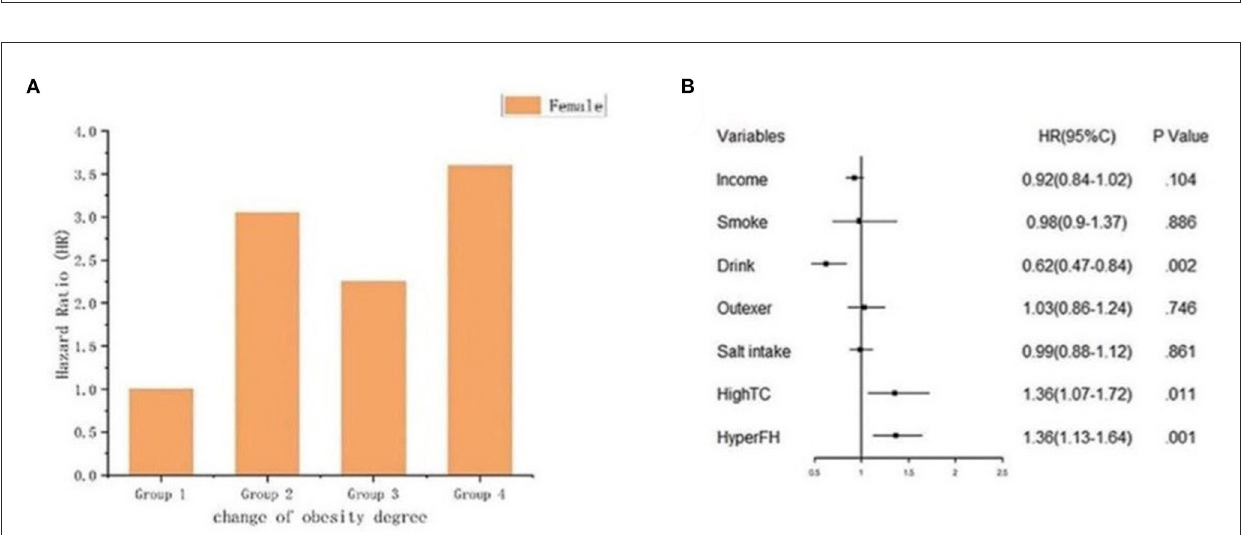
FIGURE8 The graph indicated the risk of female with hypertension onset. (A) Bar plot; (B) Forest plot of the association between female and hypertension onset based on cox regression analysis. The association was adjusted for income, smoke, drink, outdoor activity, salt intake, high total cholesterol history and hypertension family